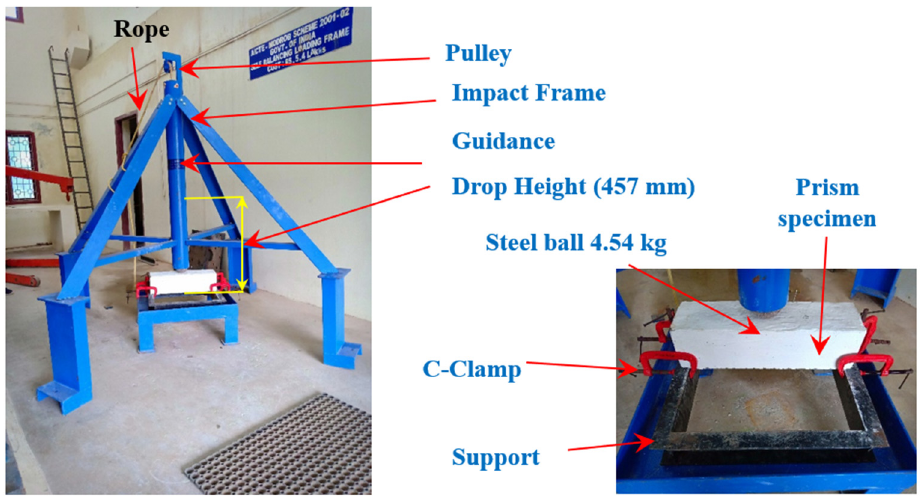
Figure 5. Testing setup for impact strength.